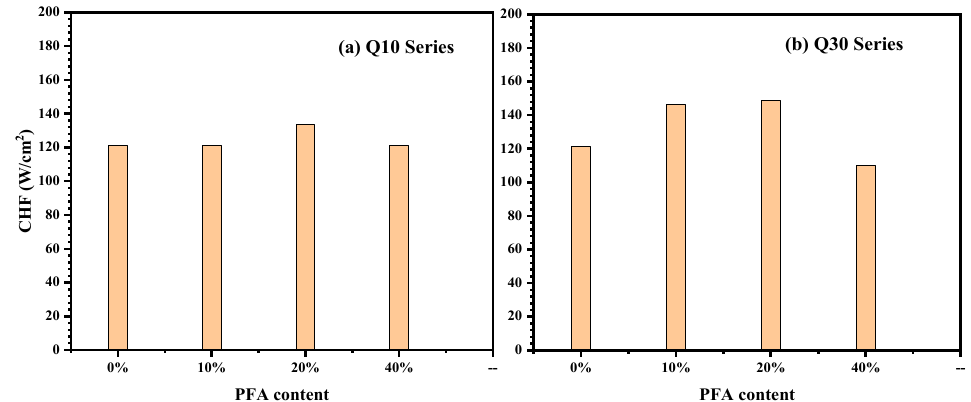
Figure 15. The relationship between PFA content and CHF for Q10 series and Q30 one. ( a ) Q10-series; ( b ) Q30-series.